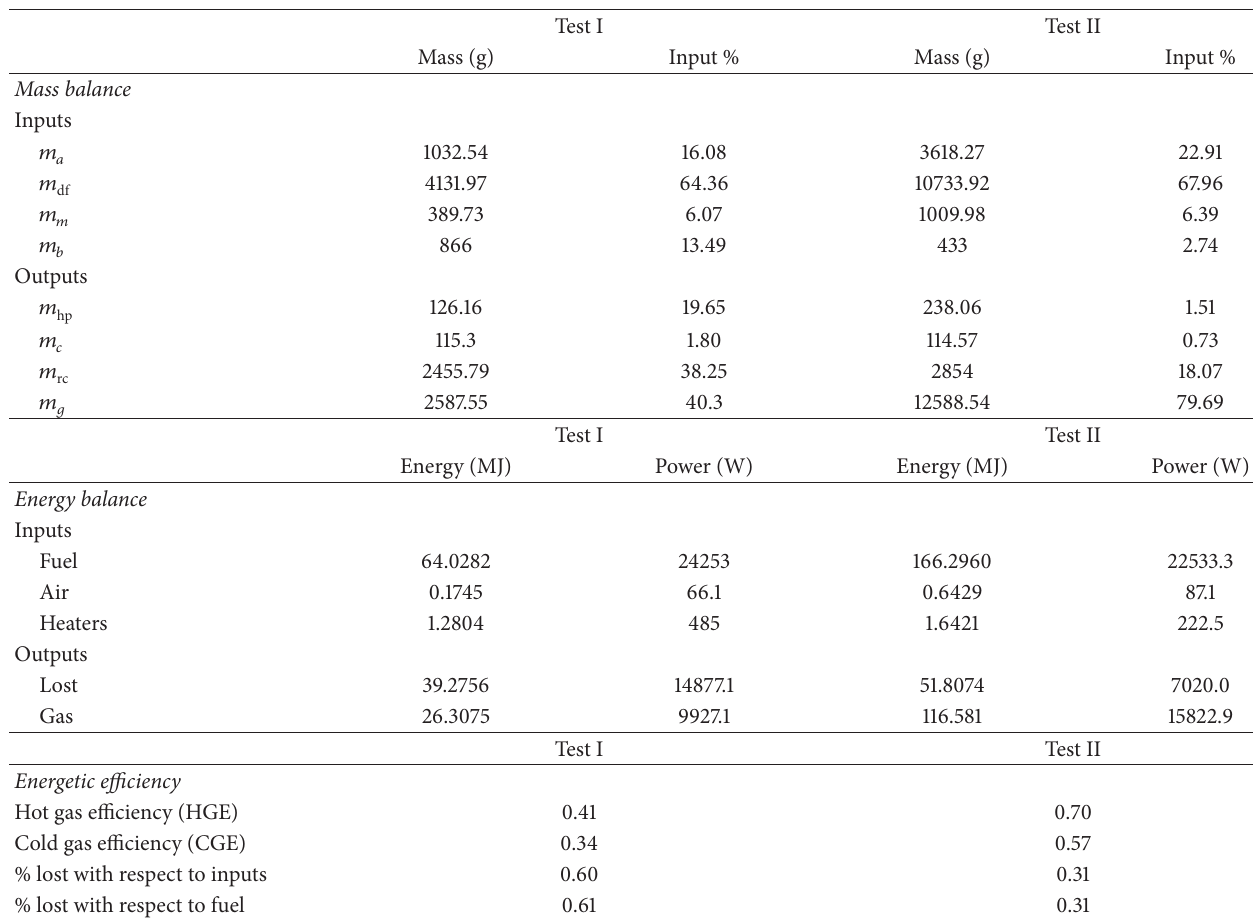
Table 4: Mass balance, energy balance, and energetic efficiency parameters for tests I and